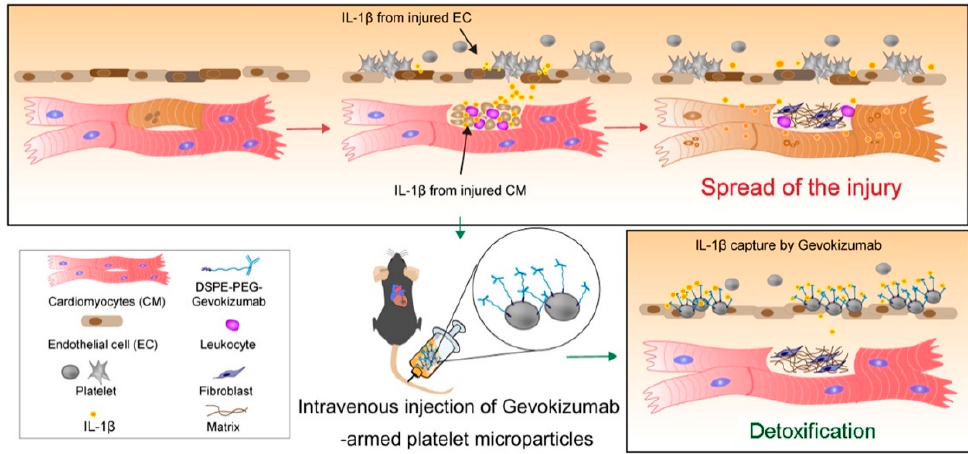
Figure 4. Schematic illustrating the role of Gevokizumab-armed platelet microparticles as cardiac detoxification and repair agents. By taking advantage of the natural infarct-homing abilities of platelet membranes, a platelet-mimicking system that uses anti-IL-1 β -neutralizing antibodies was developed in this study. This system functions as an IL-1 β decoy that reduces the local inflammatory response in the injured heart in a targeted way. Reproduced with permission [159].